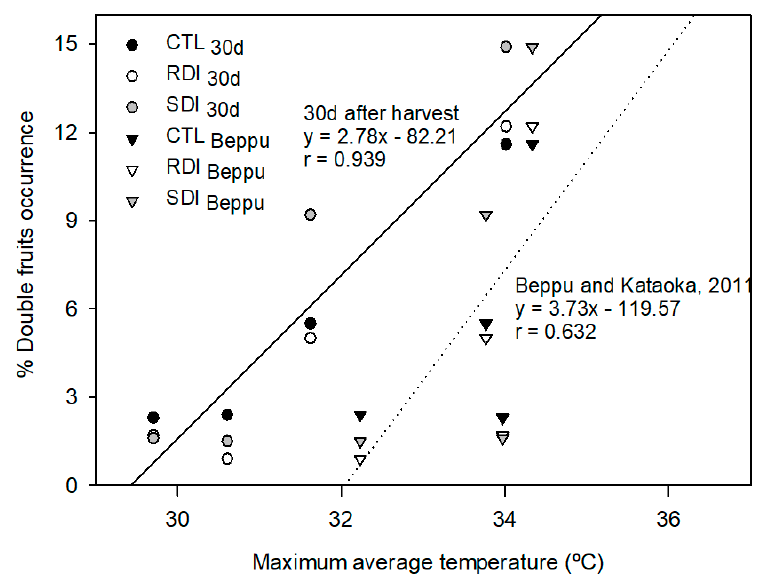
Figure 5. Relationships between maximum average temperature during the 30 days after harvest or 30 days between mid-July and mid-August (period reported by Beppu and Kataoka [19] and the % of double fruits occurrence. Each observation corresponds to the average value for each treatment and year (n = 4).